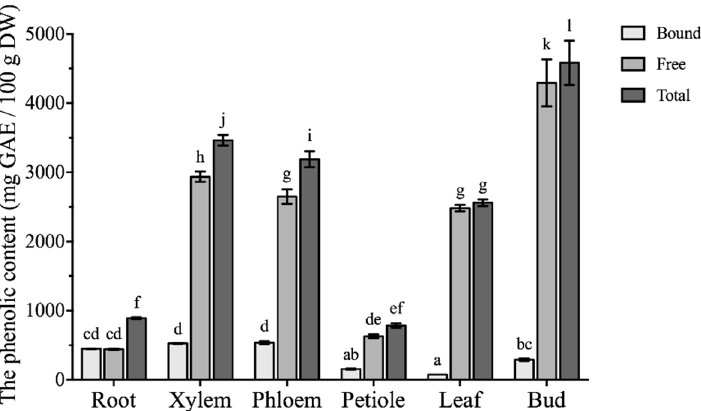
Figure 2. The phenolic contents of different vegetative parts from Boehmeria nivea L. (mean ± SD, n = 3). Bars with different letters indicate significant differences among the samples (p < 0.05).